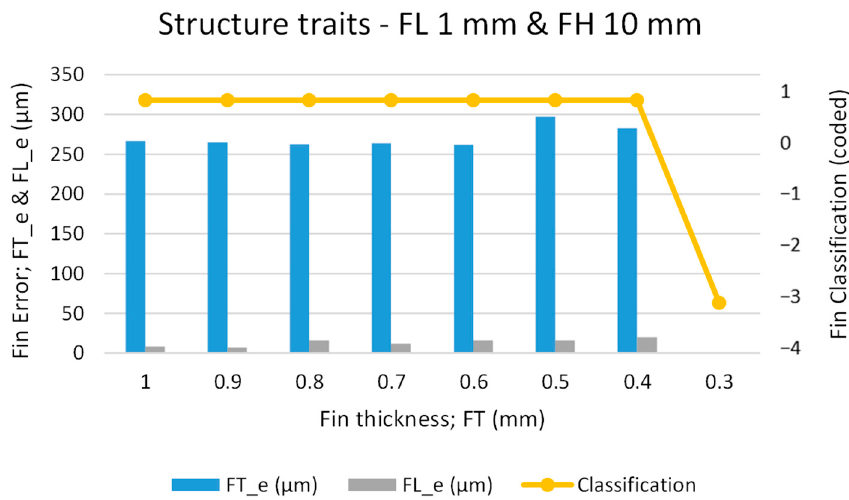
Figure 5. Graphical analysis of structure traits in the first phase of experimentation.